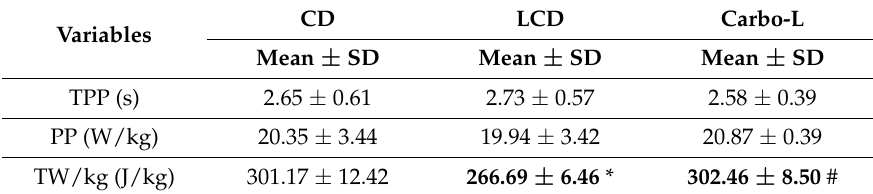
Table 3. Anaerobic variables of the Wingate test after particular dietary interventions in basketball